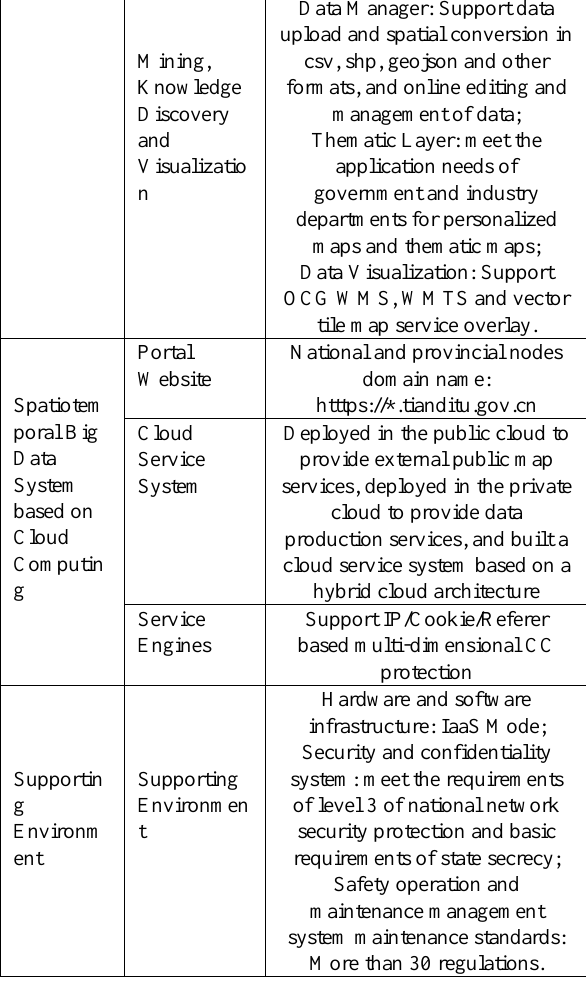
Table 1 . The detailed indicators of